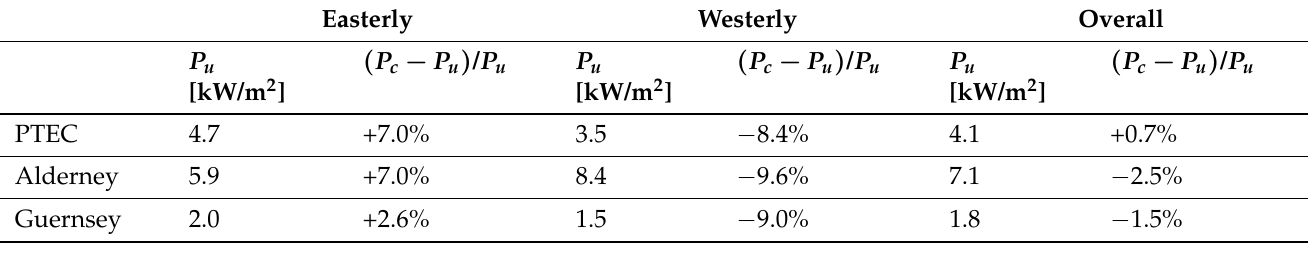
Figure 5. Difference in flow power from uncoupled and coupled models against flow power from uncoupled model. Blue points indicate positive easterly components while green points indicate negative easterly components. Table 2. Mean values of flow power density from uncoupled model, P u , and percentage difference in flower power density from coupled model, P c , relative to uncoupled model.